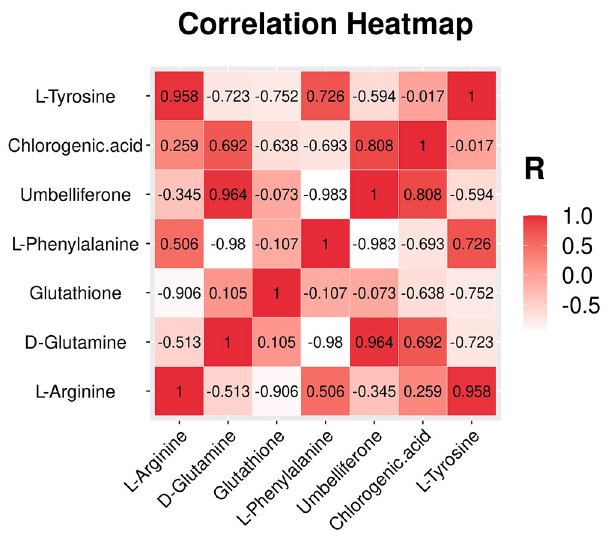
FIGURE 4 | Heatmap based on pairwise Pearson’s correlation of significant metabolites.